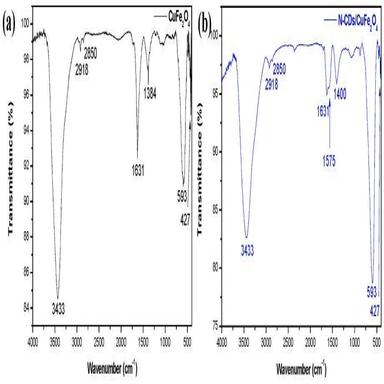
FT-IR spectra of (a) CuFe2O4 and (b) N-CDs/CuFe2O4. (A colour version of this figure can be viewed online.)